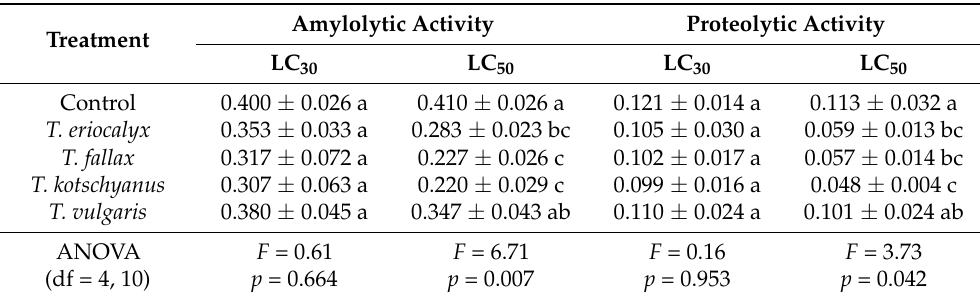
Table 5. The effects of LC 30 and LC 50 values of Thymus eriocalyx , T. fallax , T. kotschyanus , and T. vulgaris essential oils on amylolytic (mg maltose/min/individual) and proteolytic (mU/individual) enzyme activity (mean ± SE) of Rhyzopertha dominica